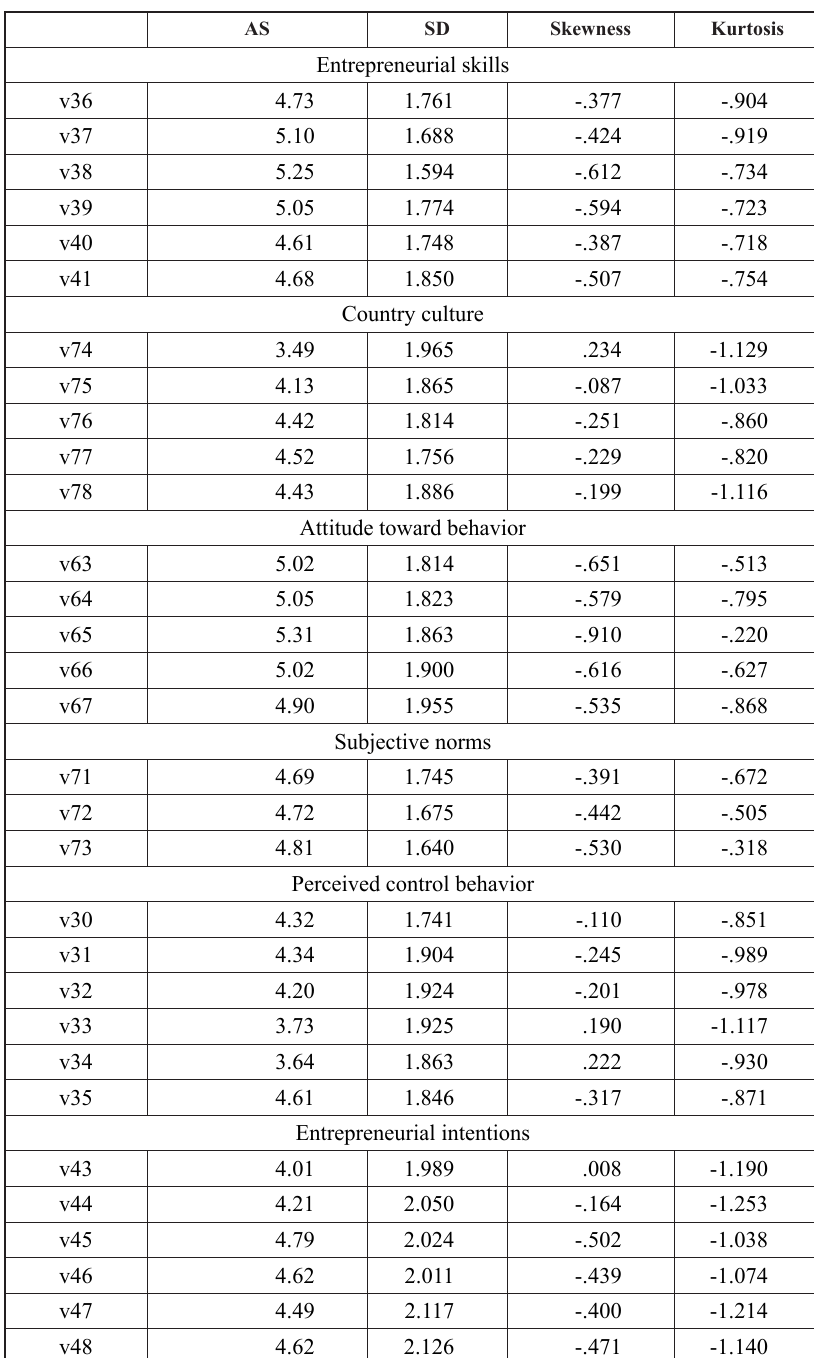
Table 1. Descriptive statistics